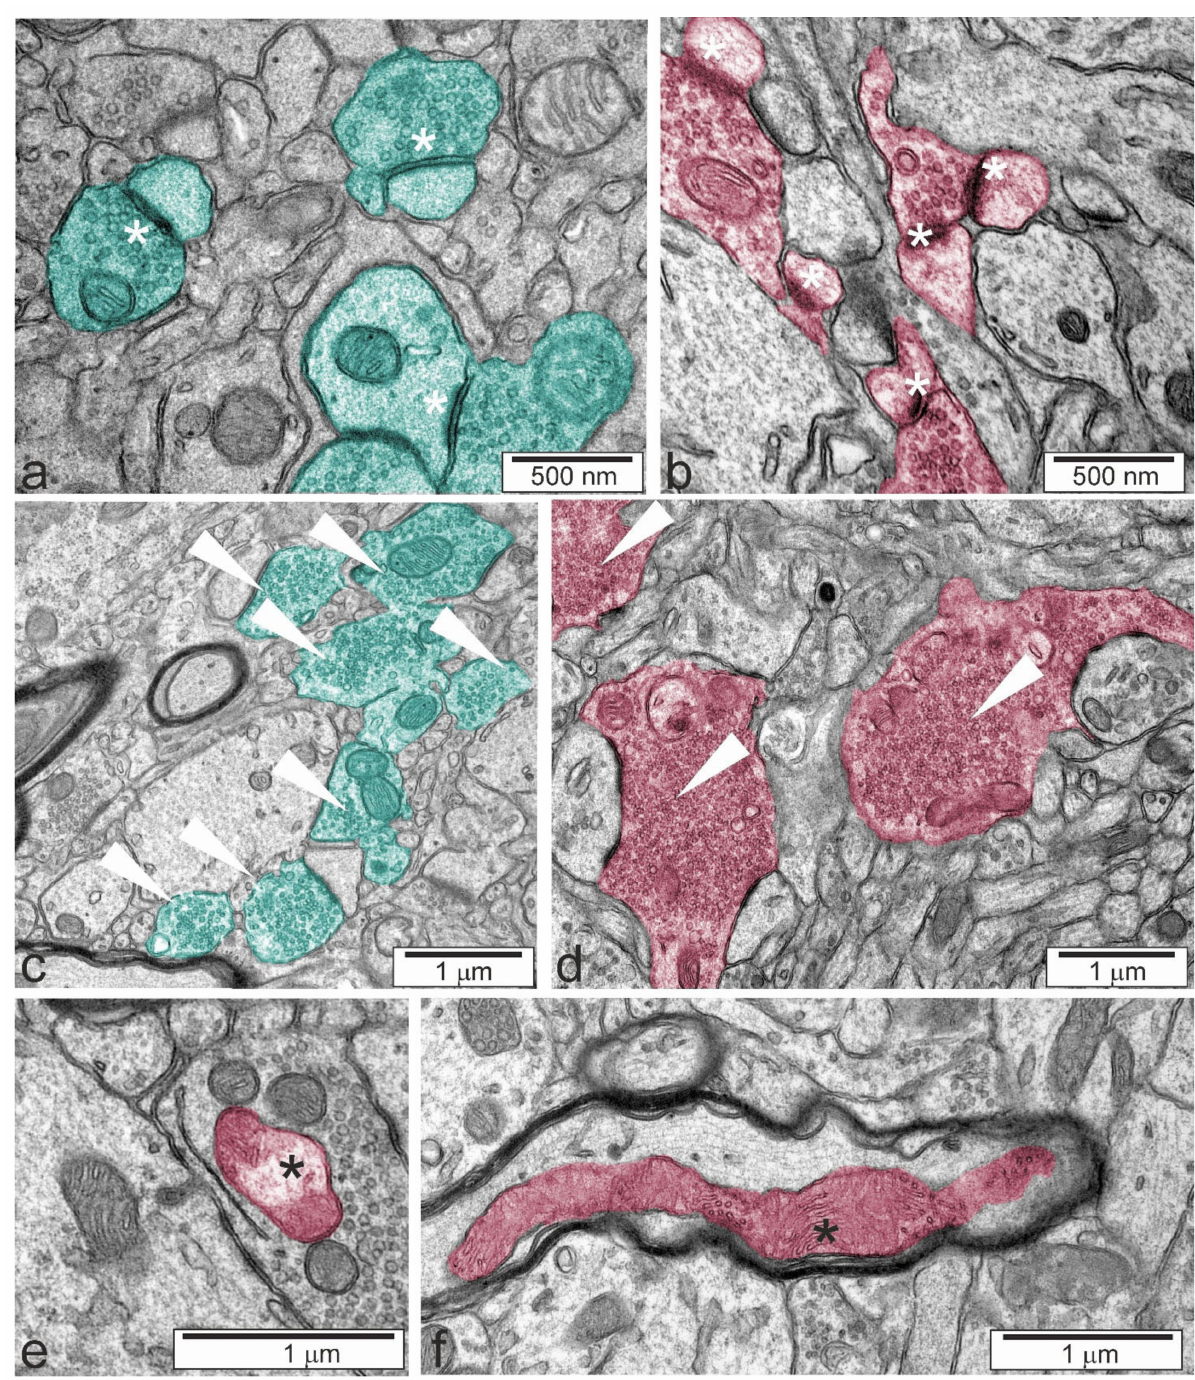
Figure 4. Typical electronograms presenting morphological alterations of neuronal cells in the hippocampus. ( a ) Correct synaptic density (white asterisk), ( b ) blurred structure for synaptic density (white asterisk), ( c ) correct synapses (arrowheads), ( d ) overloaded synaptic endings (arrowheads), ( e ) swollen mitochondrium (black asterisk), and ( f ) excessively elongated mitochondrium (black asterisk). The colour was used to label control (turquoise) and altered (reddish)